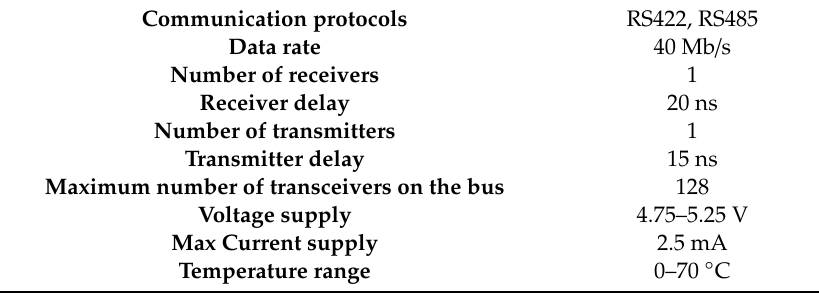
Table 4. Specifications of the Maxim Integrated MAX3468CSA chip used in the RS485